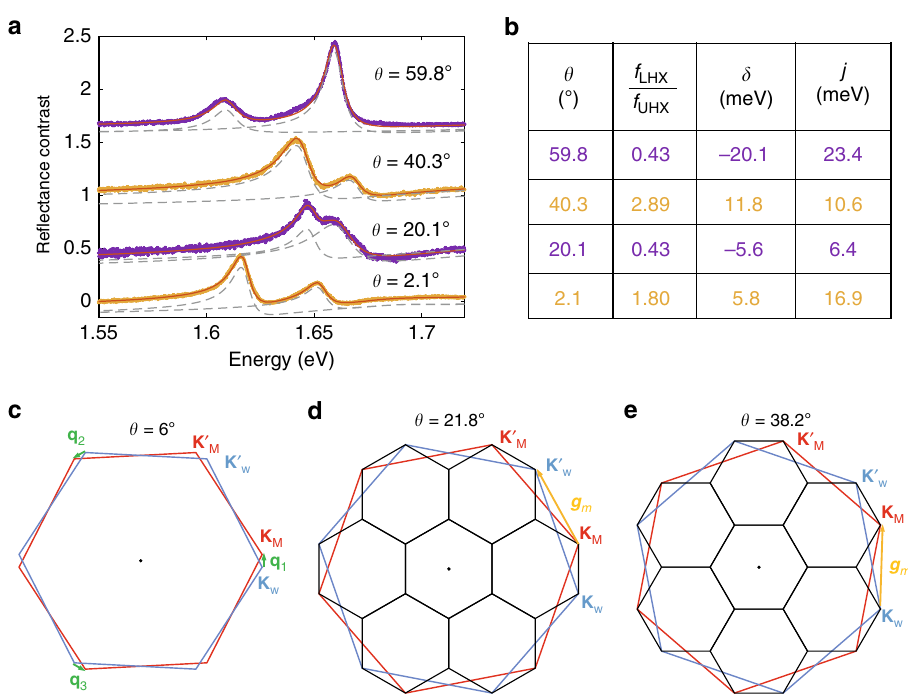
Fig. 3 Hybridization in commensurate moiré lattices compared with aligned bilayers. a RC spectra of bilayers with θ = 2.1°, 20.1°, 40.3°, and 59.8°. The LHX has a higher (lower) spectral weight than UHX in bilayers with θ = 2.1° and 40.3° ( θ = 59.8° and 20.1°). Dots are the data, solid lines are fi ts, and dashed lines are the fi tted individual hybrid exciton resonances. b Summary of the fi tted parameters for the RC spectra in a , showing similarities between bilayers with θ = 2.1° and 40.3° and between bilayers with θ = 59.8° and 20.1°. c – e Schematics of the Brillouin zones of twisted bilayers. The red (blue) hexagons depict the Brillouin zones of MoSe 2 (WS 2 ) monolayers. In c , the twist angle is 6 ∘ . The green arrows indicate vectors q 1 , q 2 , and q 3 , which represent the momentum shift between the Brillouin zone corners of the two monolayers. In d , θ = 21.8°, a commensurate moiré lattice is formed, with the corresponding moiré Brillouin zone depicted by the black hexagons. The yellow arrow represents the moiré reciprocal lattice base vector that connects K M and K 0 . In e , θ = 38.2°, which is another commensurate angle dual to 21.8°, and K M and K W become equivalent states in the moiré Brillouin W